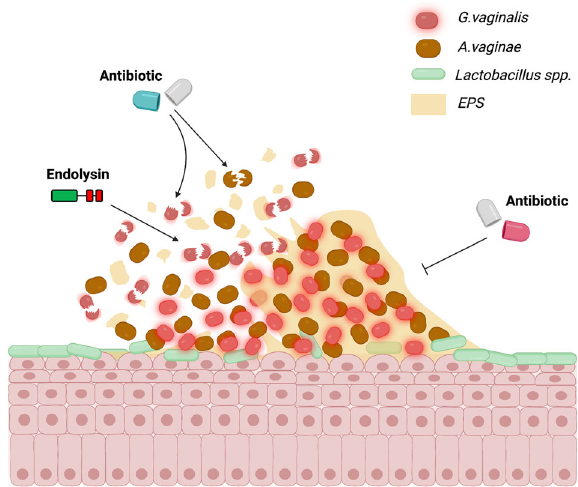
Fig. 8 Proposed combined endolysin antibiotic therapeutic : The presence of recalcitrant bio fi lms typically mean that front line antibiotics are infective when treating G. vaginalis associated BV (right). Here we suggest that the lytic activity of phage endolysins leads to bio fi lm disruption and increased activity of front-line antibiotics (left) potentially leading to greater effective clearance and lower recurrence rates. Figure created using